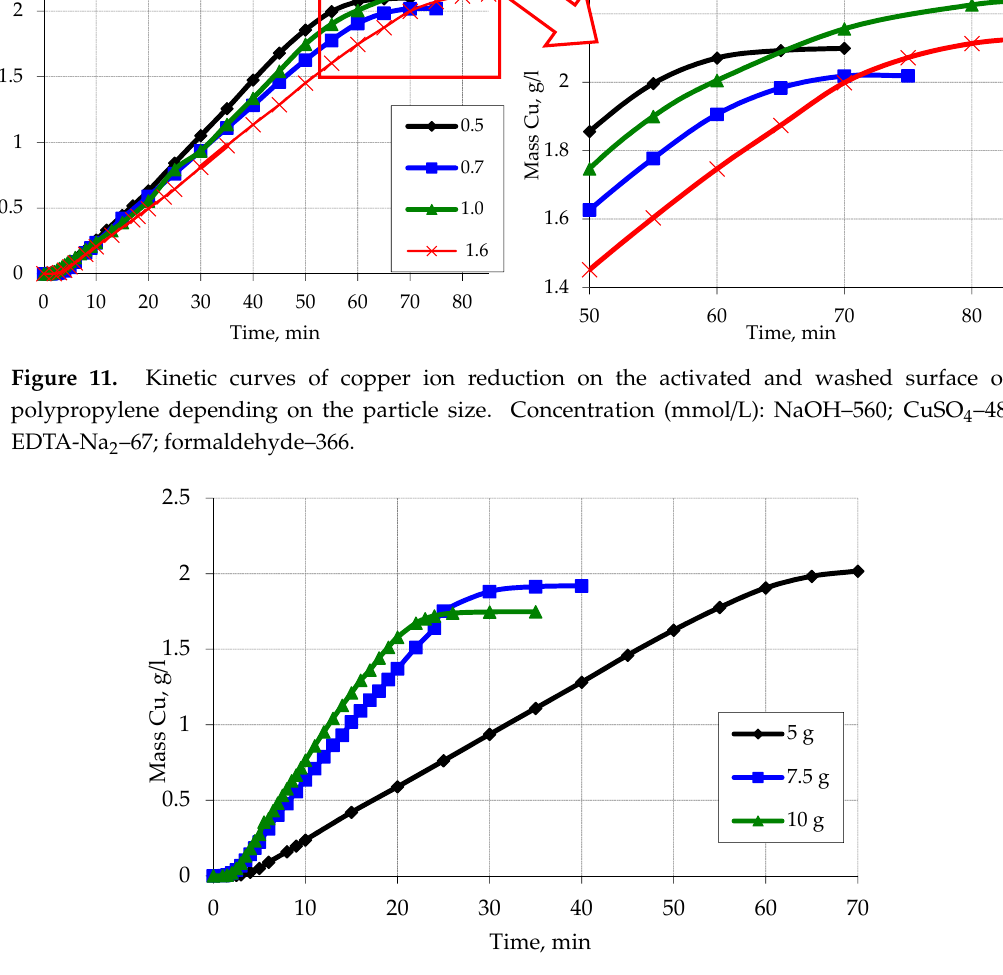
Figure 11. Kinetic curves of copper ion reduction on the activated and washed surface of polypropylene depending on the particle size. Concentration (mmol/L): NaOH–560; CuSO 4 –48; EDTA-Na 2 –67; formaldehyde–366.